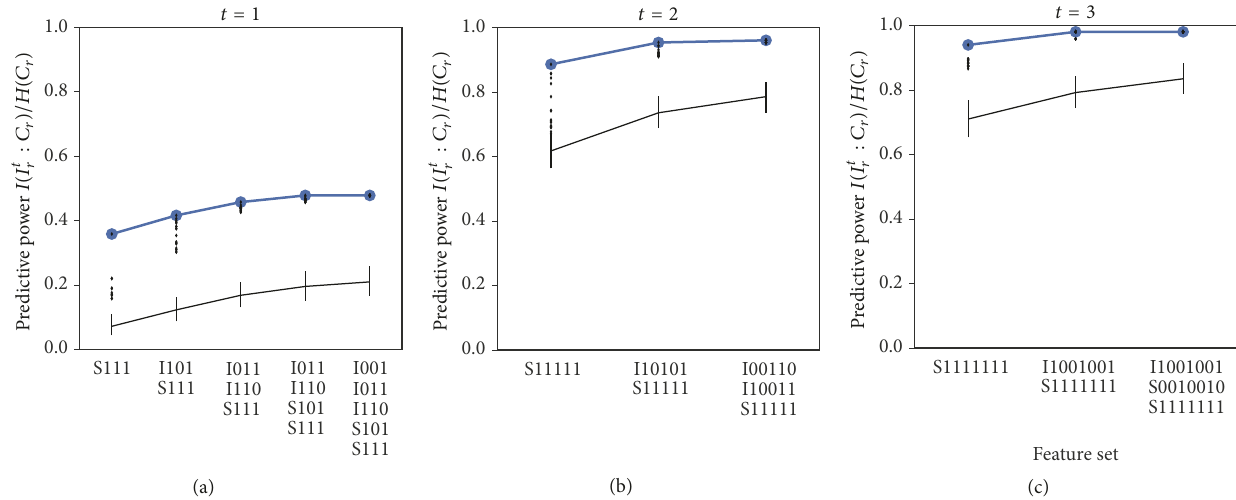
Figure 2: Predictive power of the optimal set of 𝑛 information features as function of 𝑛 (thick blue line with round markers). For each 𝑛 the best set of information features is listed: S means “synergy” and I means mutual information, followed by a bitmask of which neighbor cell’s initial state is included in the feature (middle bit is the cell itself). For example, I010 indicates the “memory” feature 𝐼(𝑋 1 𝑖 : 𝑋 0 𝑖 ) , and S111 denotes 𝐼(𝑋 𝑡=1 : 𝑋 𝑡=0 ) − ∑ 𝐼(𝑋 𝑡=1 : 𝑋 𝑡=0 ) . The thin black line with error bars is the “base line” predictability for 𝑛 features, obtained 𝑗 𝑖 𝑖 𝑗 by randomizing the pairing of 256 information features with their class identifier. The error bar indicates the 95% confidence interval of the distribution of predictive power under the null-hypothesis of zero correlation between information features and class identifier. Finally, the small black markers indicate the predictive powers of all other information feature